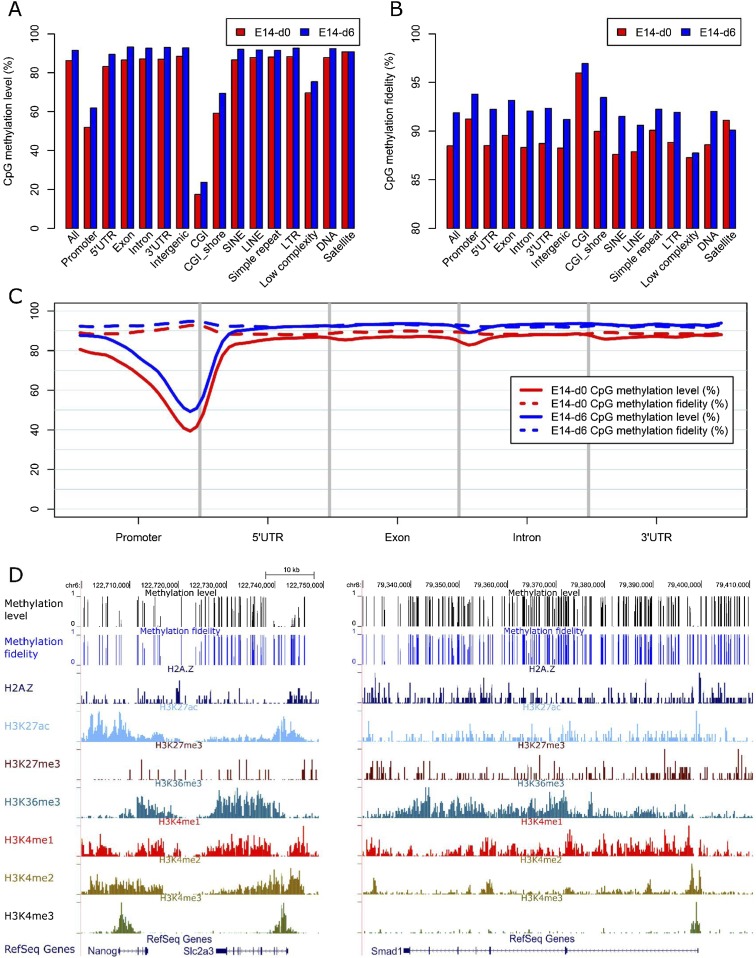
Characteristics of DNA methylation level and fidelity for CpG dyads at different genomic regions. (A,B) Bar plots showing the methylation level (A) and fidelity (B) of CpG dyads at different genomic regions. (C) CpG methylation level and fidelity along different gene-associated regions. The smoothed lines represent the mean methylation level (solid lines) and fidelity (dashed lines). (D) Genome browser representation of methylation level, methylation fidelity, and various histone modifications at genes including Nanog, Slc2a3, and Smad1.